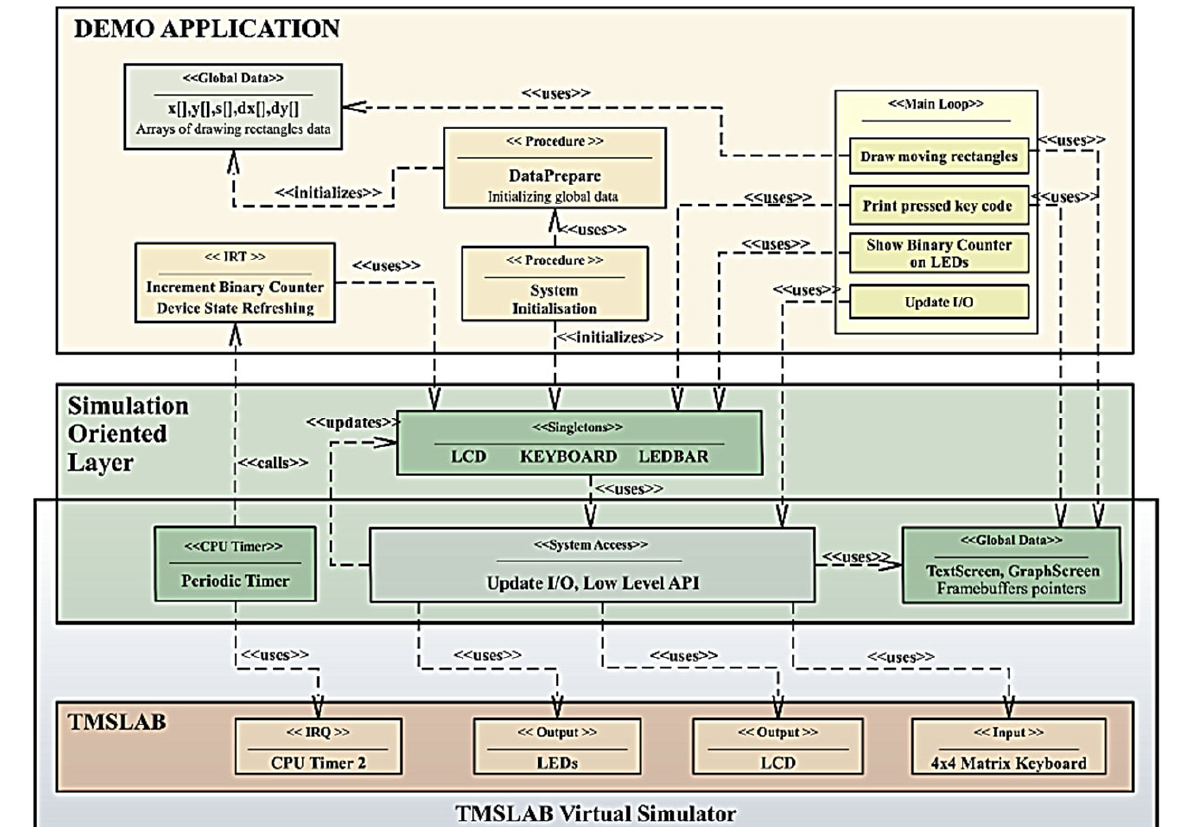
Figure 11. Demo-software-architecture diagram for real TMSLAB and its virtual Figure 11. Demo ‐ software ‐ architecture diagram for real TMSLAB and its virtual simulator .